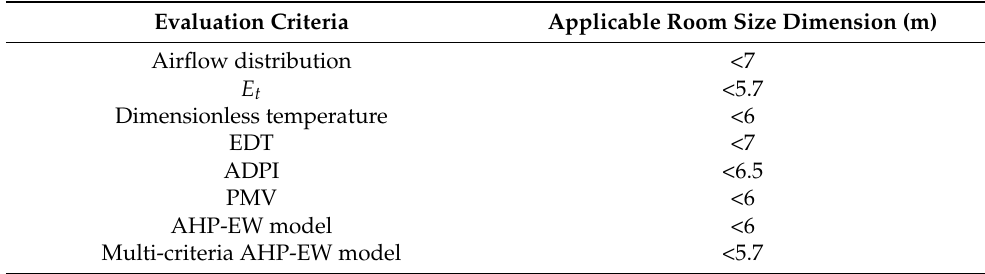
Table 5. Determination of applicable room size dimension for stratum ventilation used for